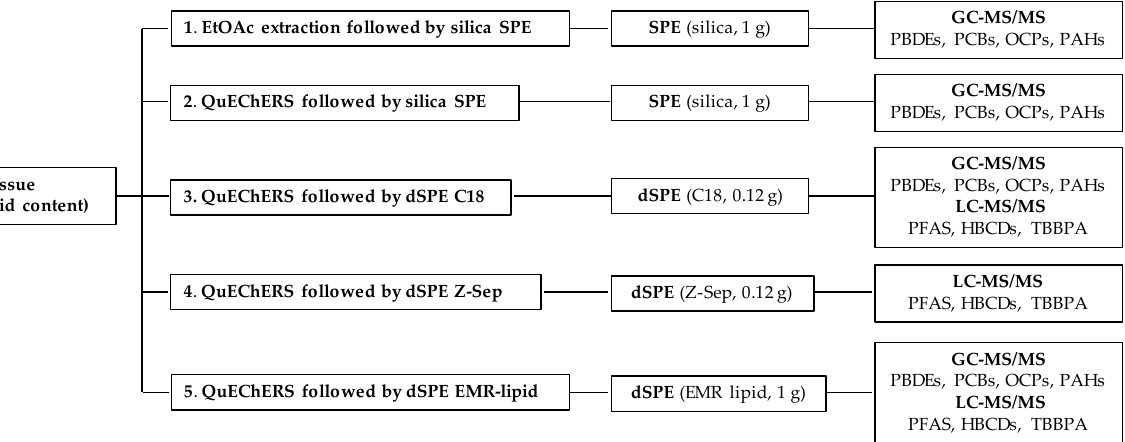
Figure 1. Flow charts of the tested methods.